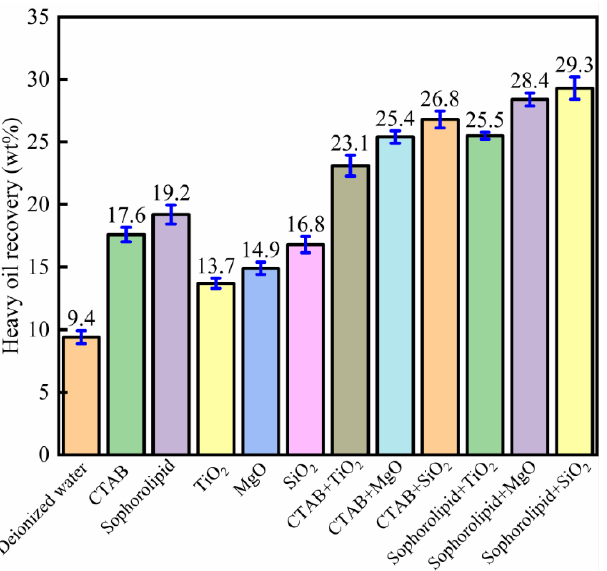
Figure 6. Heavy oil recovery from carbonate asphalt rocks using hot-water-based extraction syner- gistically enhanced with various nanofluid–surfactant solutions.